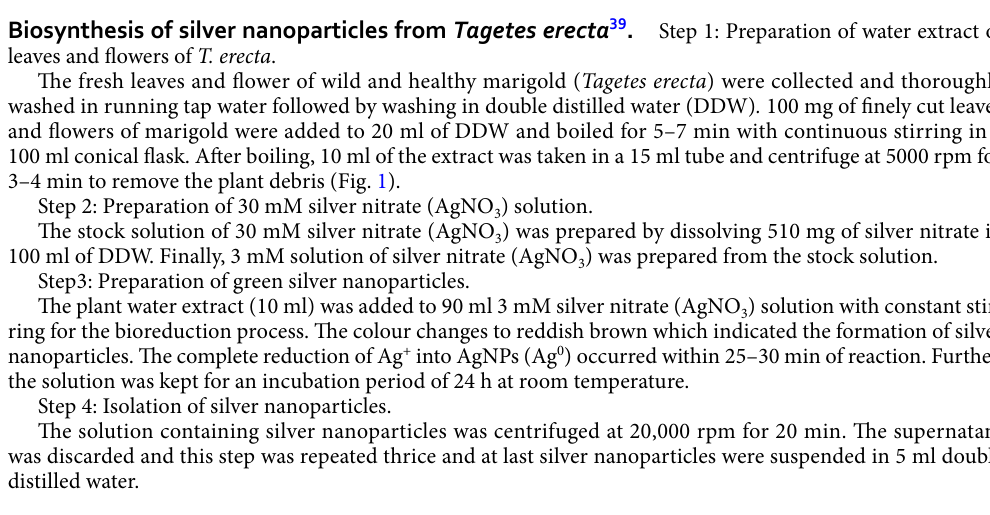
Step 1: Preparation of water extract of